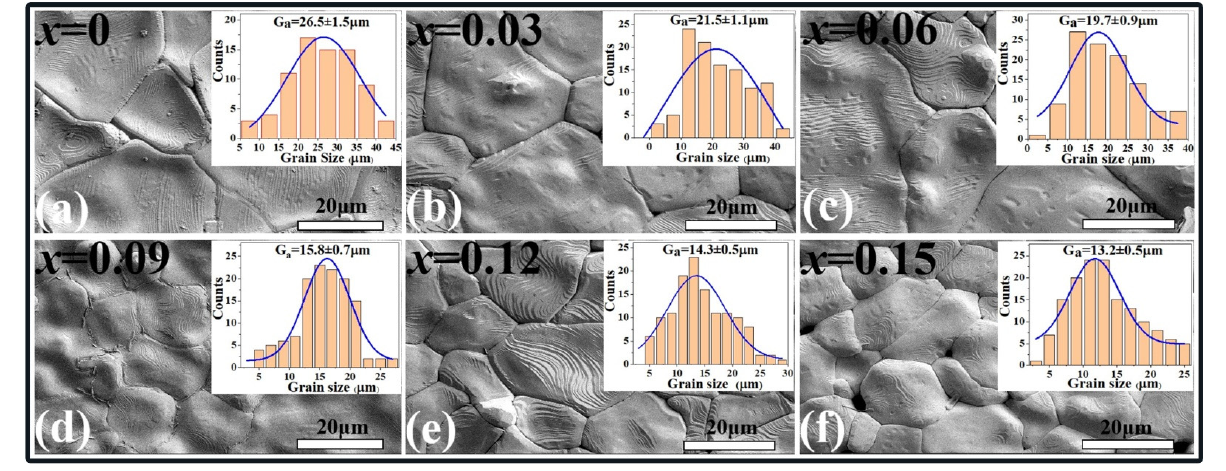
Figure 2. SEM morphologies of the (1 − x )BT- x CSZ ceramics with ( a ) x = 0, ( b ) x = 0.03, ( c ) x = 0.06, ( d ) x = 0.09, ( e ) x = 0.12, and ( f ) x = 0.15.